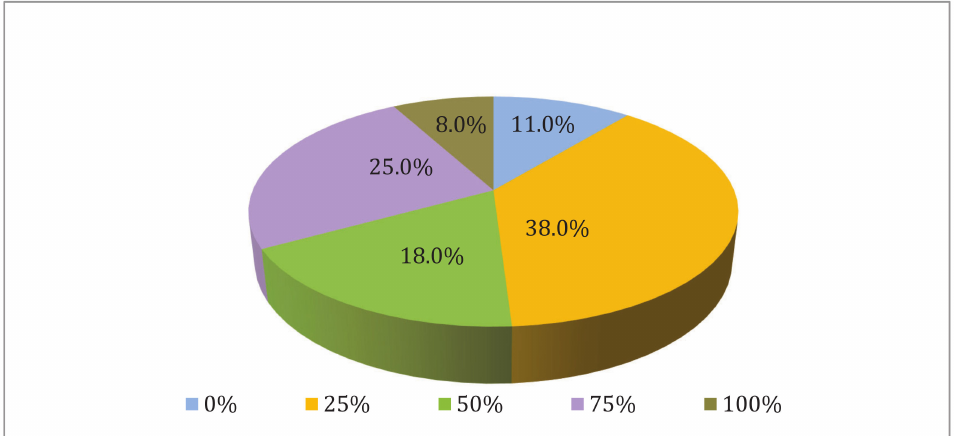
Figure 1. Distribution of the study participants according to evaluation of the Nutrition curriculum in